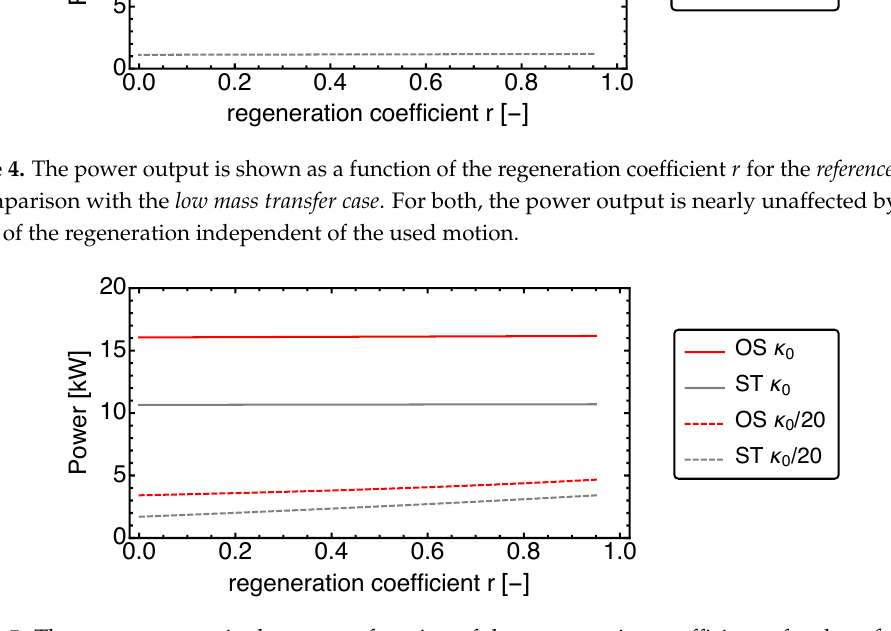
Figure 5. The power output is shown as a function of the regeneration coefficient r for the reference case in comparison with the low conductance case . While the power output for the reference case is nearly unaffected by the extent of the regeneration this is different for the low conductance case , which shows a declining power with declining